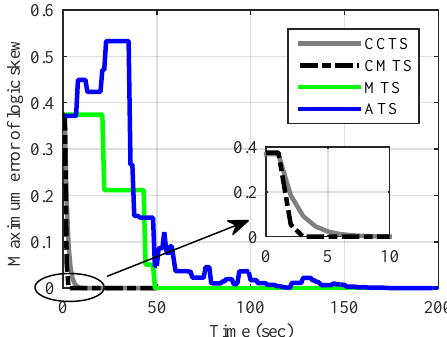
Figure 3. Comparison of convergence speed of skew in intra-cluster time synchronization among the proposed Cluster-based Maximum consensus Time Synchronization (CMTS) and the current methods.